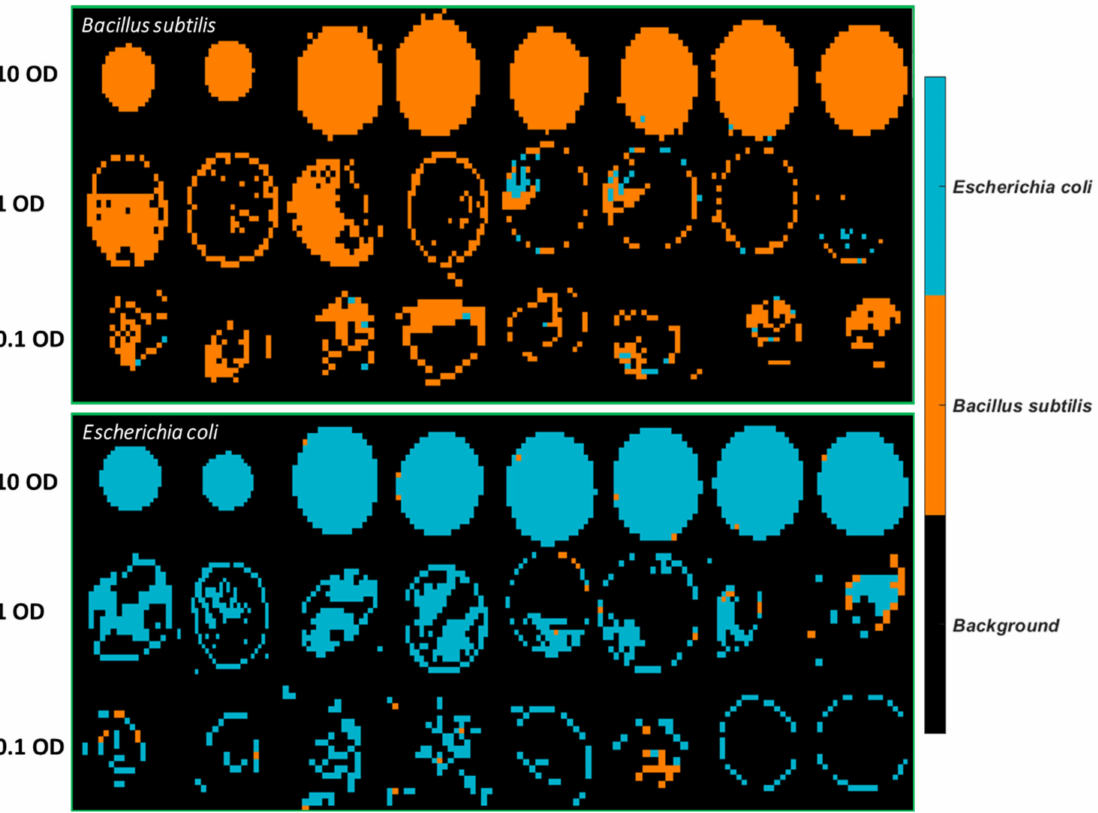
Figure 4. Classification maps obtained from the SVM model using 3500–2600 cm − 1 for all samples deposited on STS. The training set consists of the first four images of each concentration, and the test set comprises the remaining four images of each